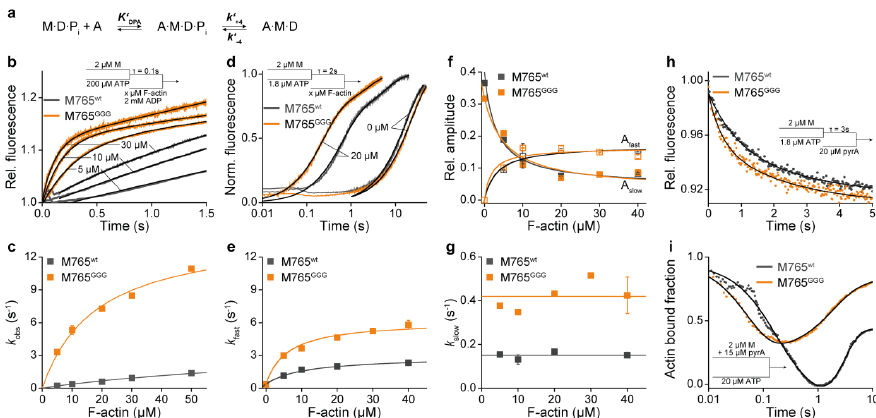
Figure 6. ( a ) Scheme of actin-activated P i release during the weak-to-strong transition. ( b ) Rate of P i release under multiple turnover conditions. An amount of 2 µM myosin was mixed with 200 µM ATP, aged for 0.1 s, and subsequently mixed with increasing F-actin concentrations in the presence of excess ADP. All solutions were supplemented with 5 µM MDCC-PBP as fluorescence-sensitive P i sensor prior to mixing. The corresponding rates of the actin-activated P i release were obtained from single exponentials fits including a slope term to account for the subsequent steady-state reaction. ( c ) Sec- ond order rate constants of actin binding to the M∙D∙P i complex ( K’ DPA k +4 ) and rate of P i release ( k’ +4 ). ( d ) Kinetics of P i release monitored with 5 µM MDCC-PBP under single turnover conditions. The fast phase corresponds to the rate of P i release and the slow phase to the rate of ATP binding, which limits the overall reaction rate. ( e ) Plots of k fast vs. actin and hyperbolic fits to the data reveal second order rate constants of actin binding to the M∙D∙P i complex ( K’ DPA k +4 ). ( f ) Graph showing the reciprocal hyperbolic dependency of the relative amplitudes of the fast phase (A fast ) and the slow phase (A slow ) on actin associated with the amount of liberated P i during a single ATP turnover. ( g ) Plot of the rate of the slow phase ( k slow ) vs. actin. ( h ) Kinetics of the weak-to-strong transition under single turnover conditions. An amount of 2 µM myosin was mixed with sub-equimolar ATP, aged for 3 s, and rapidly mixed with 20 µM pyrene-actin. Double exponential fits reveal two rate constants of actin association. ( i ) Actomyosin dissociation and association kinetics under multiple turnover conditions upon mixing a solution of 2 µM myosin and 15 µM pyrene-actin with 20 µM ATP. Transients report the fast dissociation of the complex, followed by the re-association reaction. Signals were normalized relative to the maximum fluorescence intensity of 1 that corresponds to 100% of myosin bound to actin.